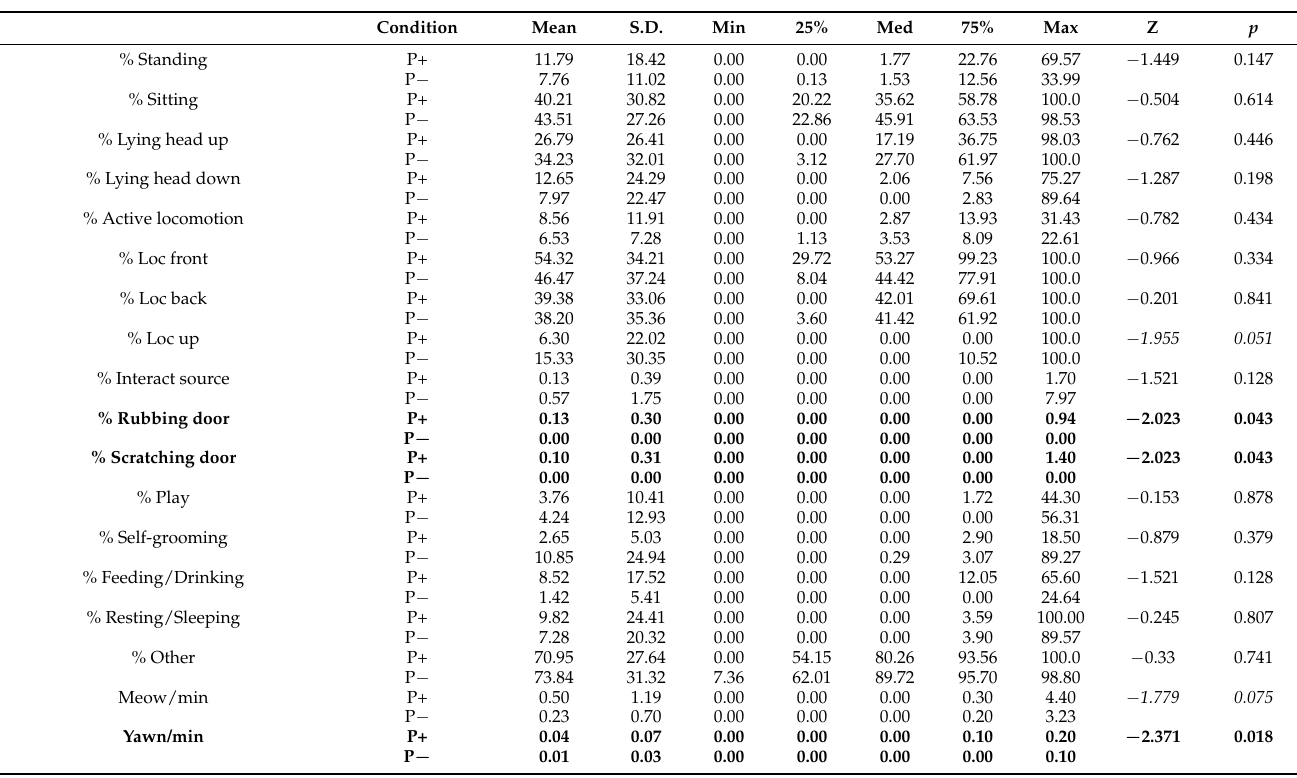
Table 6. Overview of the cat behaviours, with mean, standard deviation (S.D.), minimum (Min), lower quartile (25%), median (Med), upper quartile (75%) and maximum (Max). Wilcoxon tests were used to compare the behaviours of the cats between the two testing conditions (P+: person present, P − : person not present during the play back of the audio book). Significant differences are depicted in bold, tendencies in